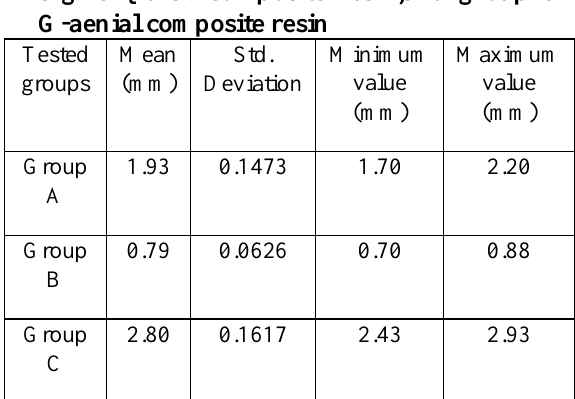
Table 2: Descriptive statistics of radiopacity values in mm for all groups. Group A Evetric composite resin, group B Estelite Sigma Quick composite resin,and group C